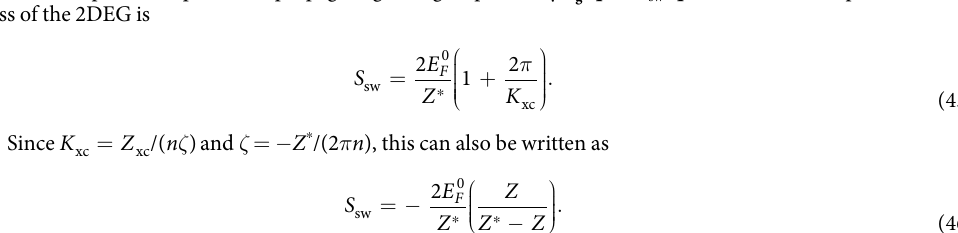
We plot the ALDA spin-wave stiffness for various values of the spin polarization ζ and as a function of the 2D Wigner-Seitz radius r s in Fig. 5. The stiffness has negative values for all practically relevant values of r s , and crosses over to S sw > 0 for very low densities (at r s = 26.96 for ζ = 0.05 and at r s = 24.49 for ζ = 0.95). In practice, one is interested in studying collective modes in the typical metallic range of r s between about 2 and 6; this is the inter- 1 ) is comparable to the kinetic energy mediate coupling regime where the Coulomb energy (which scales as − r s 2 ), but which can still be regarded as weakly correlated. As an example, in the quantum well (which scales as − r s system considered in ref. 37 the spin-wave stiffness was S sw = − 27.6, for r s = 2.2 and ζ = 0.053.